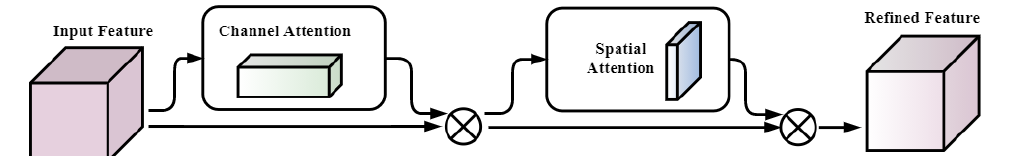
Appl. Sci. 2022 , 12 , 9105 Figure 7. Convolutional Block Attention Module structure. Figure 7. Convolutional Block Attention Module structure.